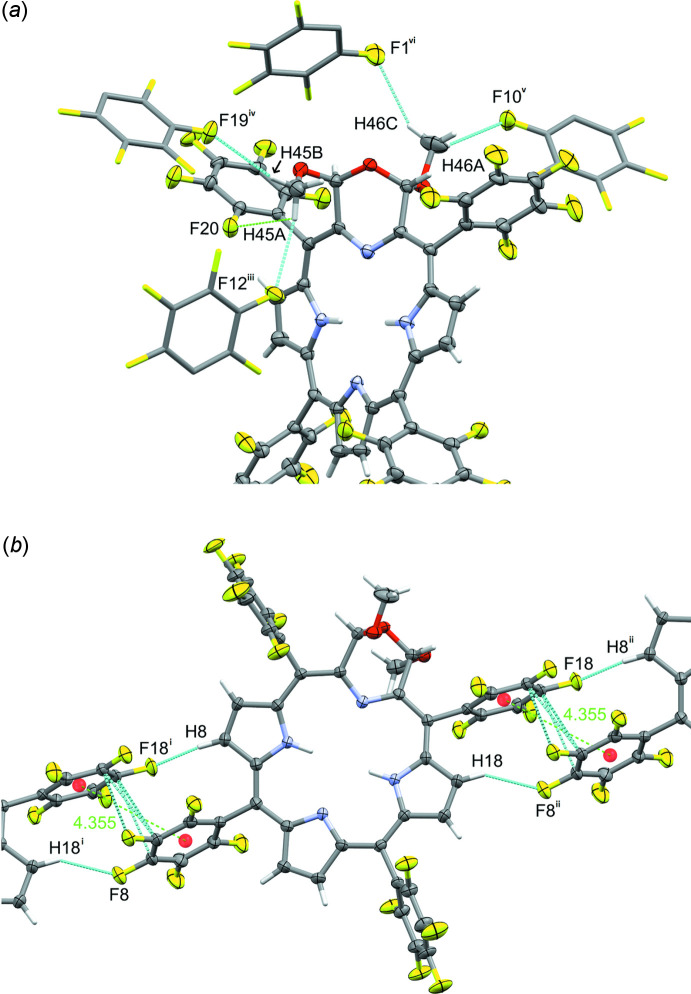
(a) C—H⋯F inter­actions involving the meth­oxy hydrogen atoms (turquoise dashed lines). Accepting moieties are truncated to their penta­fluoro­phenyl groups, and symmetry-related atoms not directly involved in an inter­action are shown in stick mode for clarity. (b) C—H⋯F and slipped π–π stacking inter­actions (turquoise dashed lines) connecting mol­ecules into infinite chains. Red spheres indicate the centroids of the respective aromatic rings, green dashed lines the distance between centroids (in Å). For symmetry codes, see Table 1 ▸.